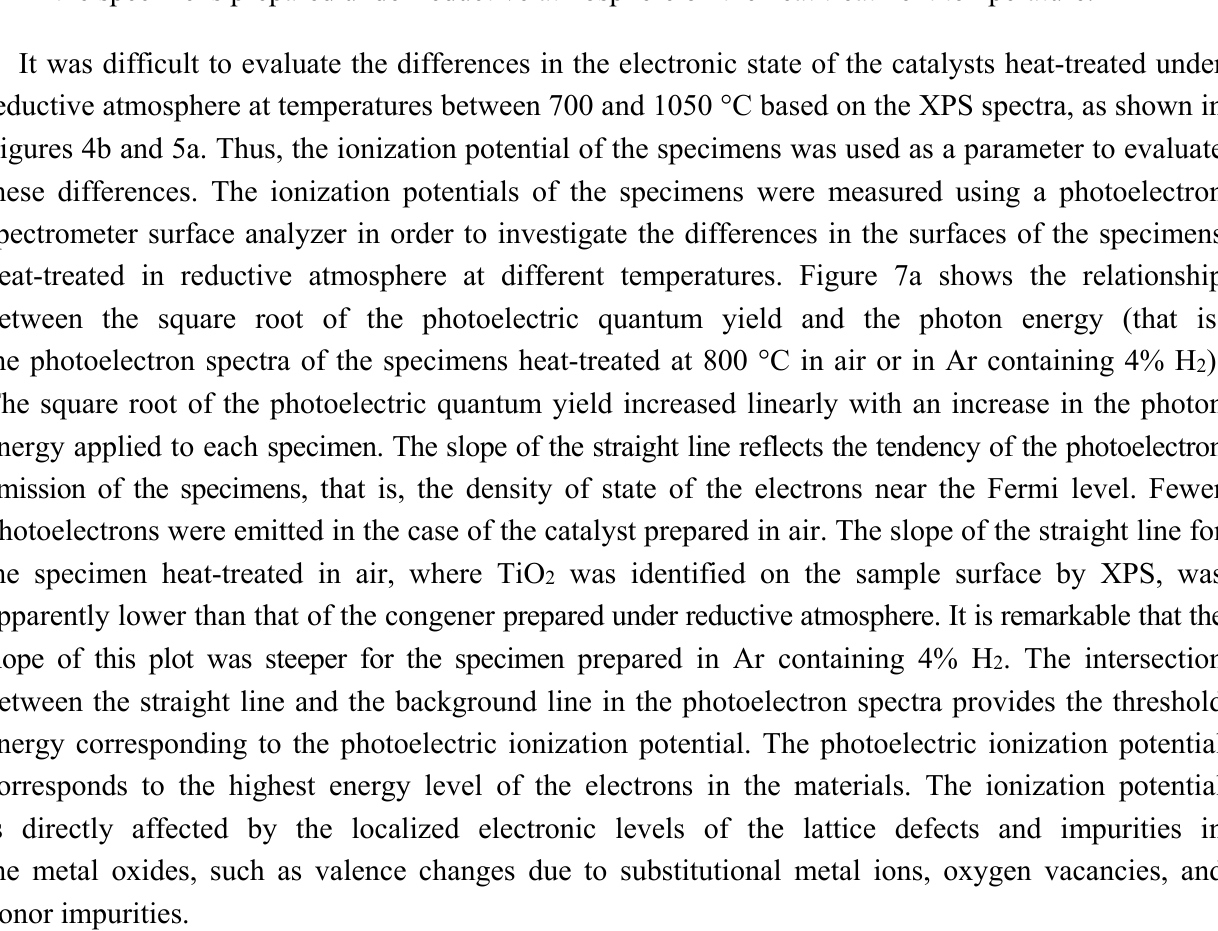
Figure 6. Dependence of the atomic ratio of Nb/Ti calculated from XPS spectra of the specimens prepared under reductive atmosphere on the heat treatment